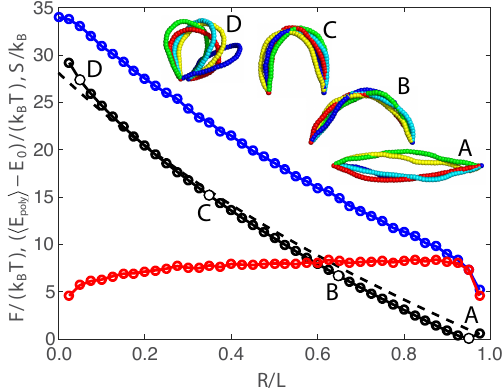
Figure 3. Thermodynamic contributions to the free energy F for a worm-like chain versus the end-to-end distance R . The free energy F (black dots) is determined using our exact analytical treatment (Equation (4)). The average polymer energy (cid:104) E poly (cid:105) − E 0 (blue dots) is found from discretized Monte Carlo simulations, and the entropy S (red dots) is calculated from S = ( (cid:104) E poly (cid:105) − E 0 − F ) / T . The dashed curve is the zero-temperature bending energy, and the four Monte Carlo conformations span the range of end